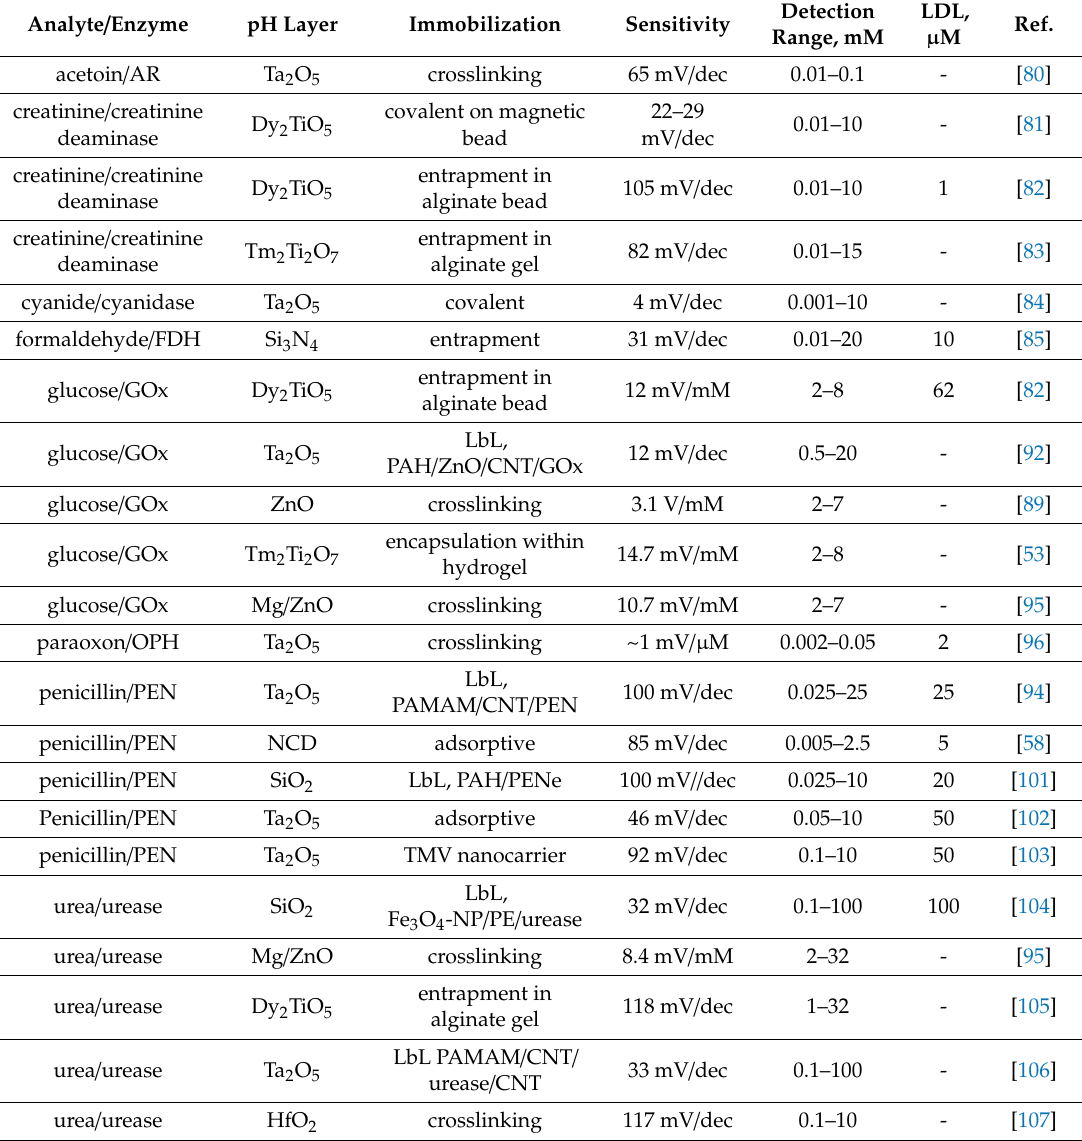
Table 2. Typical characteristics of enzyme-modified capacitive EIS (EnEIS)